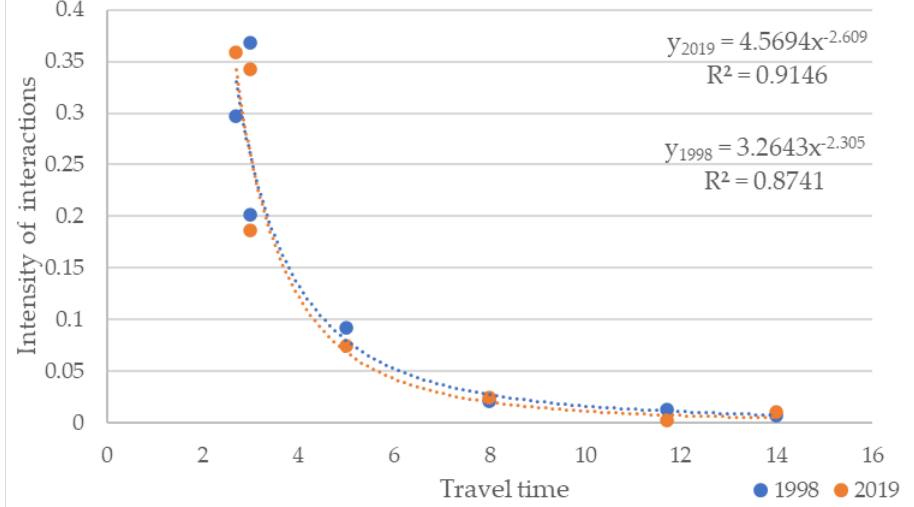
Figure 5. Intensity of interactions and travel time to Graciosa Island from the rest of the archipelago— for 1998 and 2019.